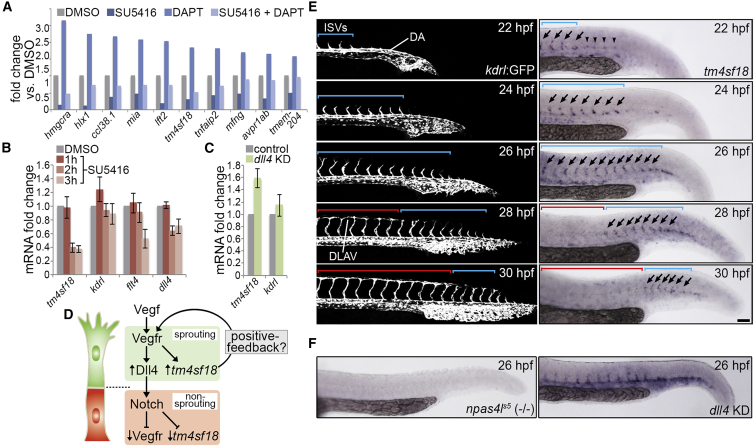
Identification of Putative Positive-Feedback Modulators of Vegf Signaling(A) Fold change in the indicated transcript levels by microarray following inhibition of Vegfr signaling (2.5 μM SU5416), Notch activity (100 μM DAPT), or both, from 22 to 30 hpf.(B and C) Fold change in tm4sf18, kdrl, flt4, and dll4 transcript levels by qPCR in embryos incubated with 2.5 μM SU5416 for the indicated times (B) and tm4sf18 and kdrl transcript levels by qPCR upon dll4 KD (C; n = 3 separate experiments).(D) Illustration of the putative transcriptional regulation of tm4sf18 by Vegf-Notch and proposed function as a positive-feedback modulator of Vegfr signaling.(E) Lateral views of sprouting ISVs in Tg(kdrl:GFP)s843 embryos (left) or WT embryos following whole-mount in situ hybridization analysis of tm4sf18 expression (right). Blue brackets indicate nascent ISVs; red brackets indicate anastomosed ISVs; arrows indicate tm4sf18-expressing ISVs; and arrowheads indicate tm4sf18 expression at regions of future angiogenic remodeling.(F) Whole-mount in situ hybridization analysis of tm4sf18 expression in npas4ls5 mutant embryos showing loss of expression, as well as upon dll4 KD showing ectopic expansion of tm4sf18 expression to the DA, consistent with de-repression of Vegfr signaling.Data are mean ± SEM. Scale bar, 100 μm.See also Figure S2.